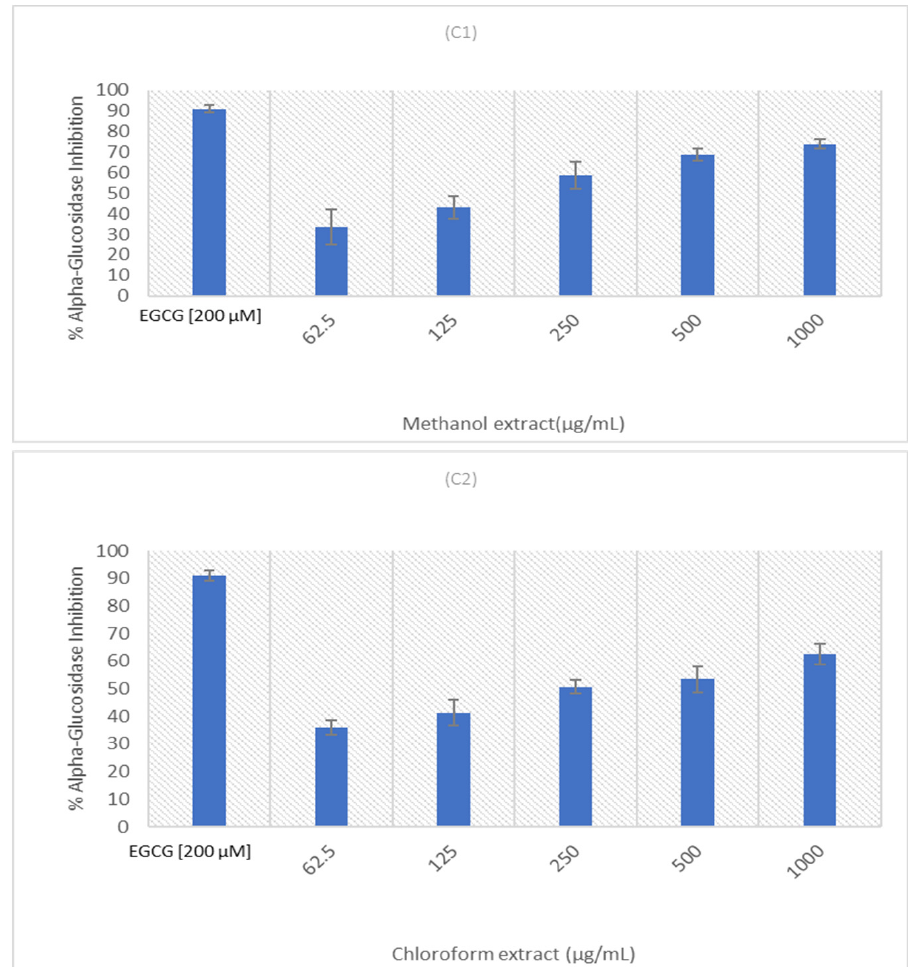
Figure 5. α -glucosidase inhibition of three samples. Epigallocatechin Gallate (ECGC) [200 μ M] was used as a positive control. Error bars indicate the standard deviation of the mean of the three replicates from a single experiment.